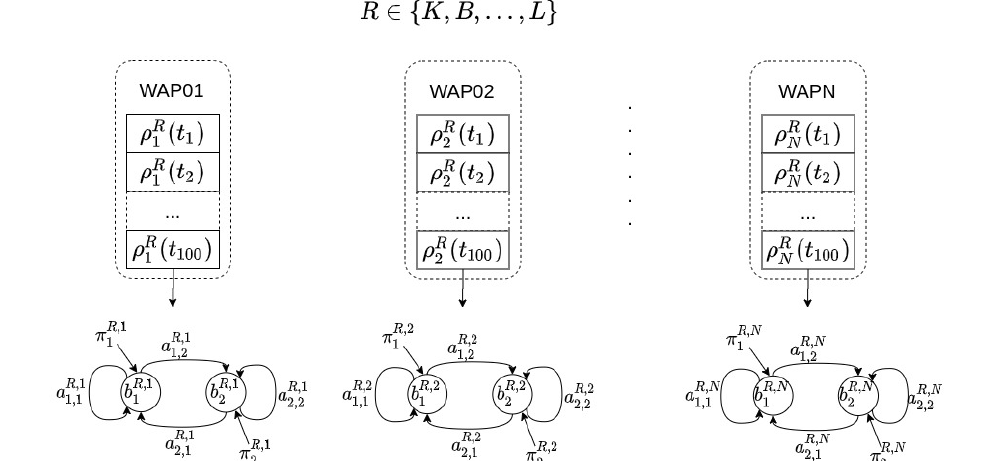
Figure 4. Offline phase. For each room ( R ) and for each time series received from a WAP present in the Wi-Fi fingerprint database, an HMM was built. Different rooms will have different parameters in their HMMs for the same WAP. Common rooms in an apartment are used in this particular example: K , B , and L stand for kitchen, bedroom, and living room. This example uses the HMM shown in Figure 5. An example of how the online phase performs is shown in Figure 6.